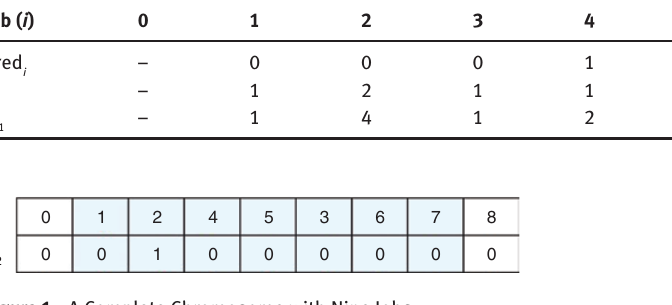
Figure 1: A Complete Chromosome with Nine